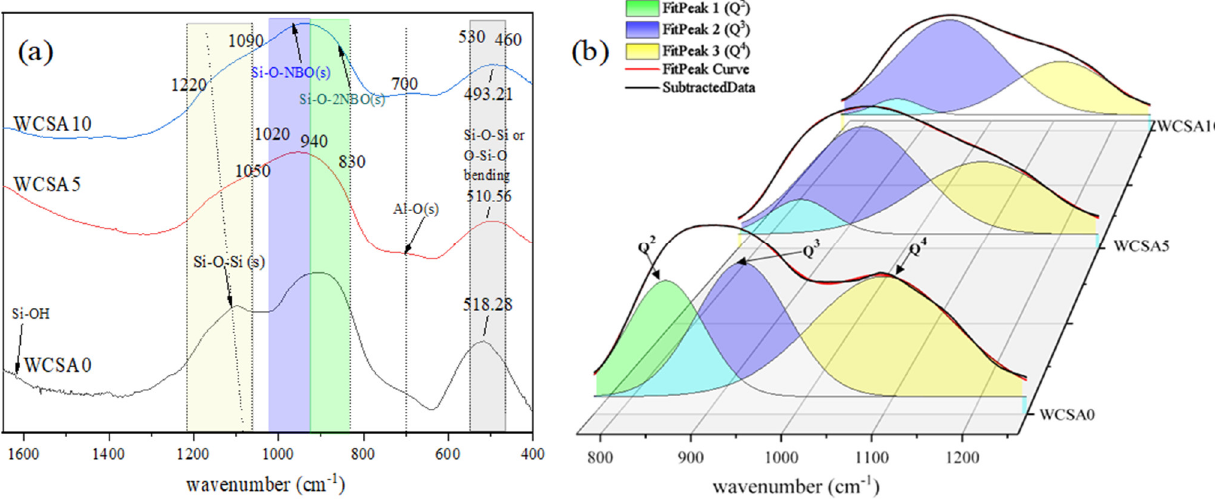
Figure 5. FTIR spectra of WCS; ( a ) original spectra and ( b ) deconvoluted spectra in the range of 773–1260 cm −1 .